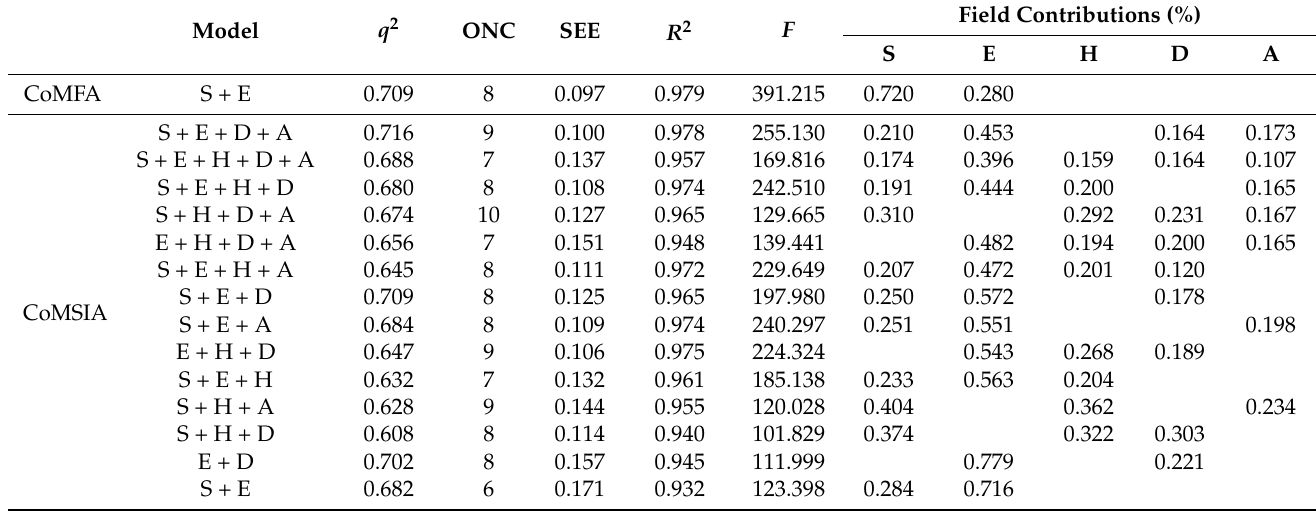
Table 1. Statistical results of the constructed 3D-QSAR models.